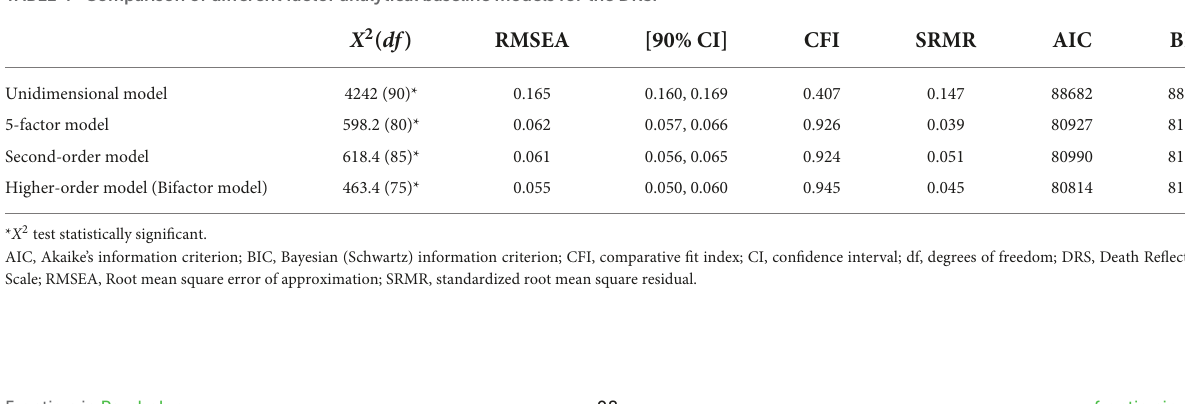
TABLE 4 Comparison of different factor analytical baseline models for the